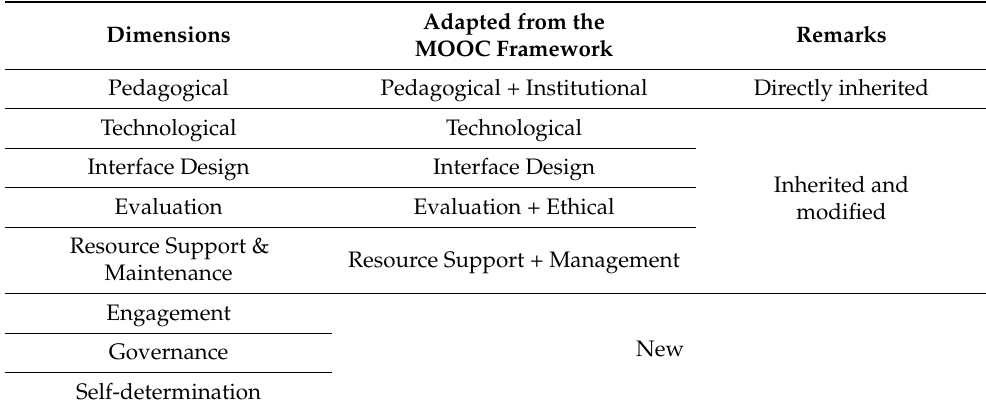
Table 5. Formulation of the C19MOOC